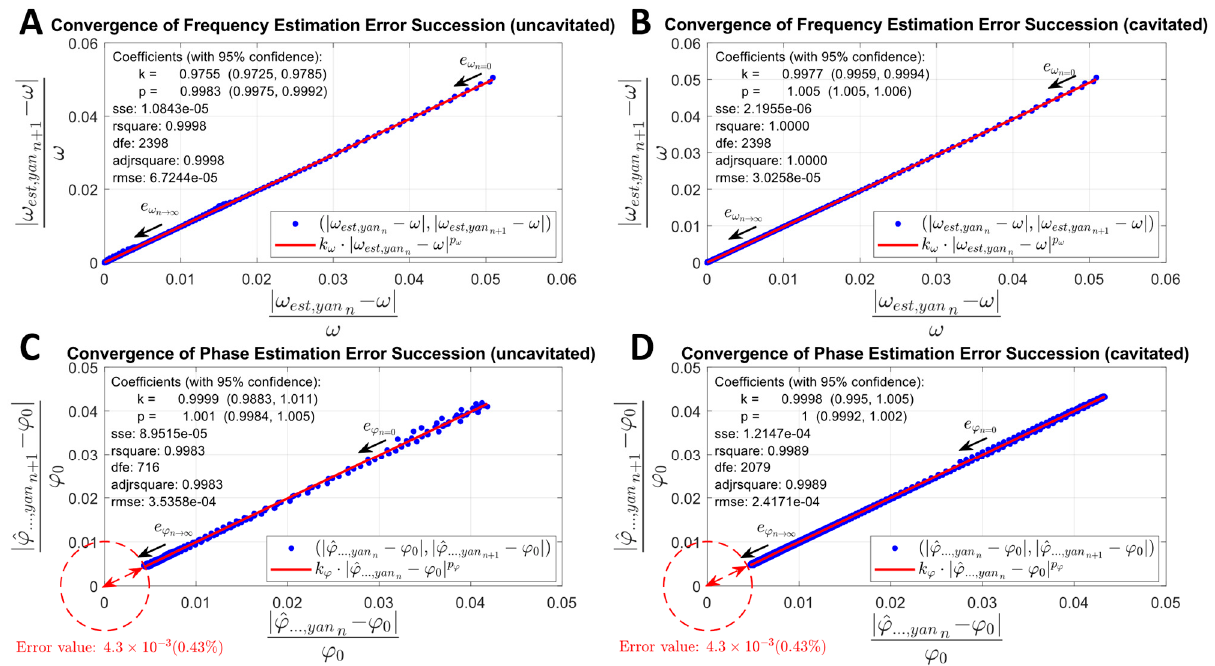
Figure 8. Convergence of frequency estimation error timeseries ( A , B ) and phase estimation error timeseries ( C , D ) for uncavitated and cavitated condition, with analytical output noise.